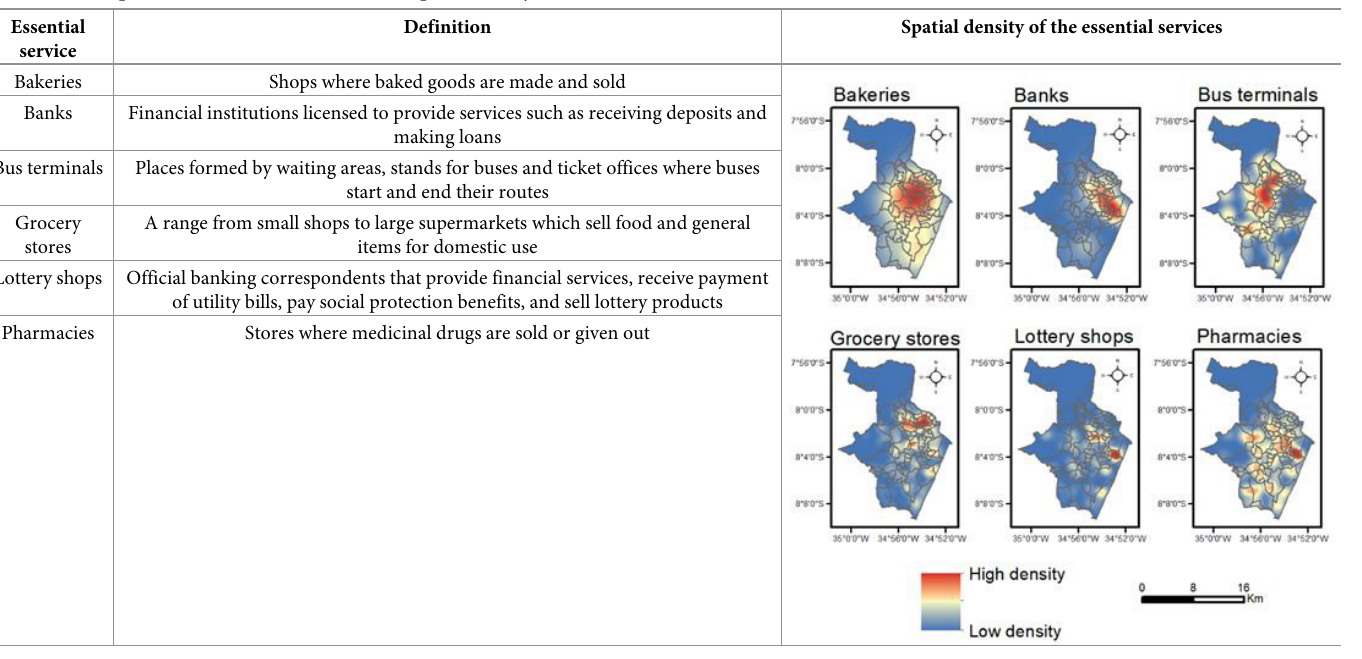
Table 2. Description of essential services and their spatial